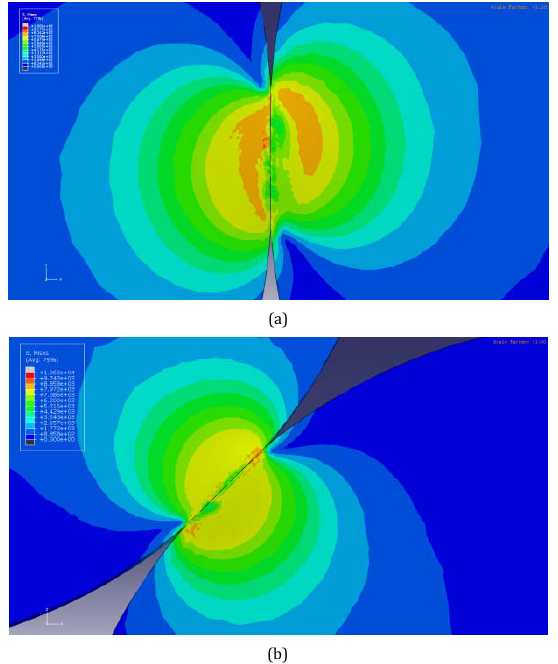
Figure 10. Von Mises stress contours at the contact points for (a) QS and (b) BCC models.